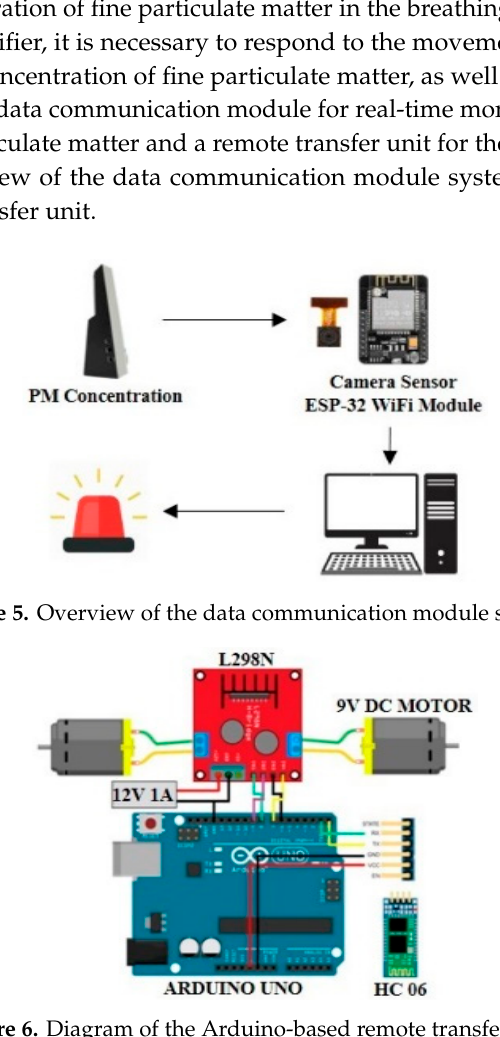
Figure 6. Diagram of the Arduino-based remote transfer unit.